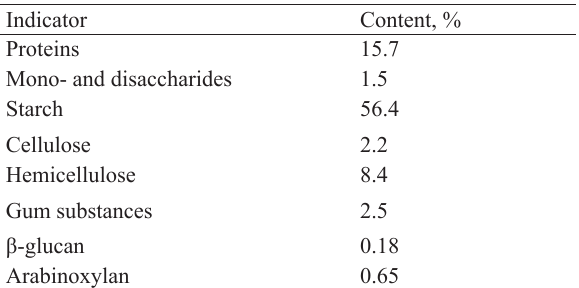
Table 1 Biochemical indicators of rye grain Table 2 Comparative activity of enzyme preparations derived from Aspergillus awamori recombinant